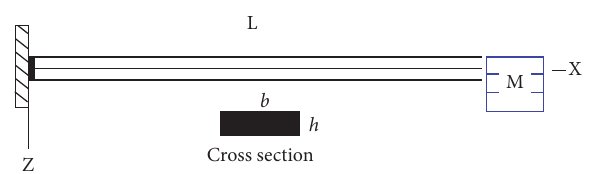
Figure 1: Cantilever beam with a mass concentrated at the free